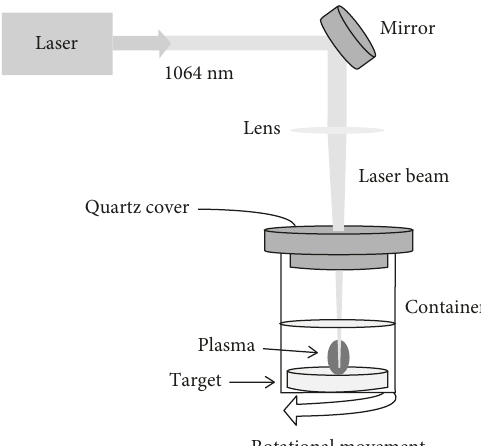
Figure 1: Schematic diagram of the experimental setup used in nanoparticles preparation by laser ablation confined in a liquid medium.